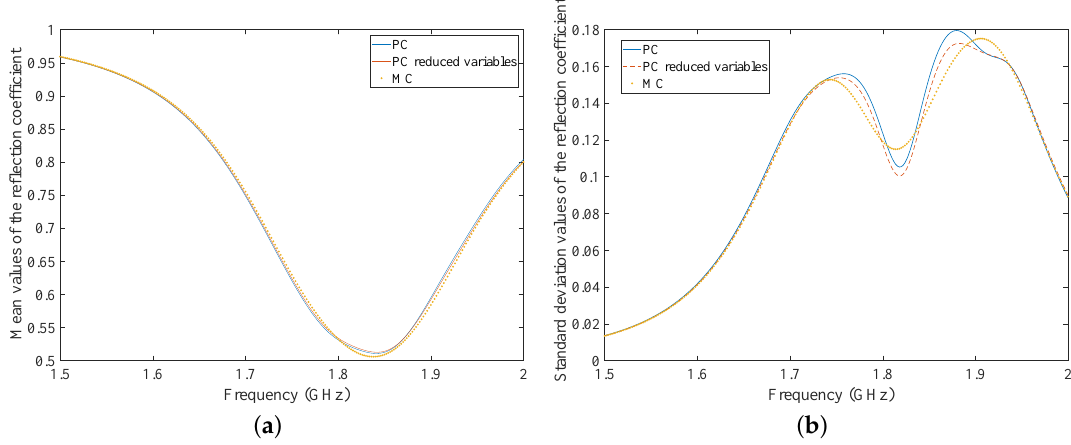
Figure 10. ( a ) Mean value and ( b ) standard deviation of the reflection coefficient for the first case of the path-antenna